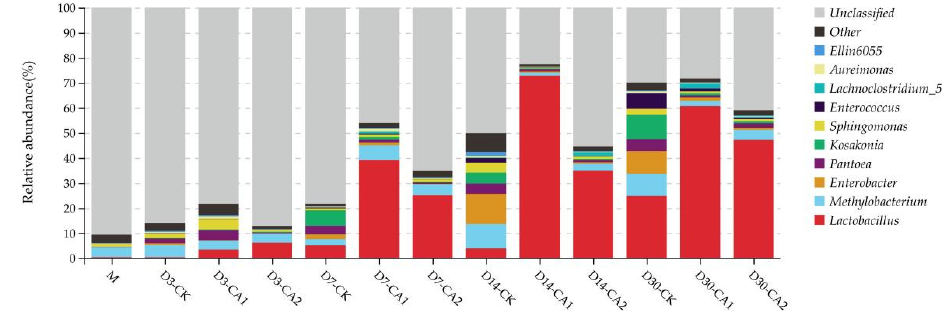
Figure 4. Bacterial community and relative abundance by genus for mulberry leaf silages (M, pre- ensiled material; CK, the control; CA1, 1% citric acid; CA2, 2% citric acid; D3, 3 days of ensiling; D7, 7 days of ensiling; D14, 14 days of ensiling; D30, 30 days of ensiling).